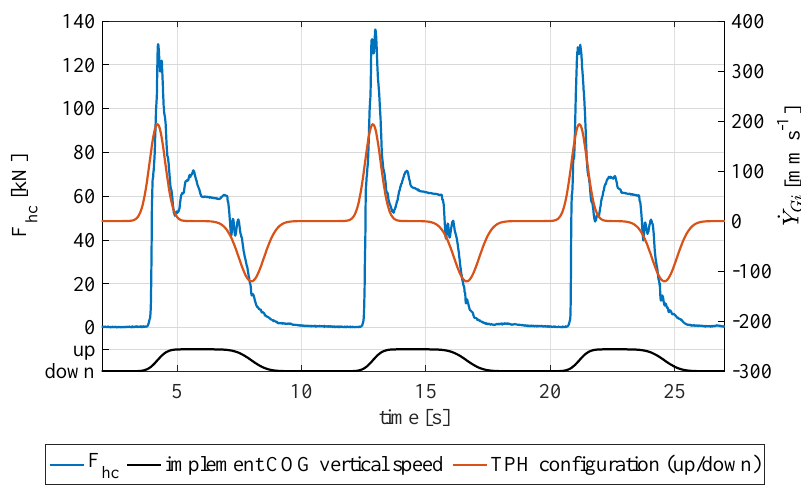
Figure 10. Relationship between the force at the hydraulic lift cylinders and the implement COG vertical speed.